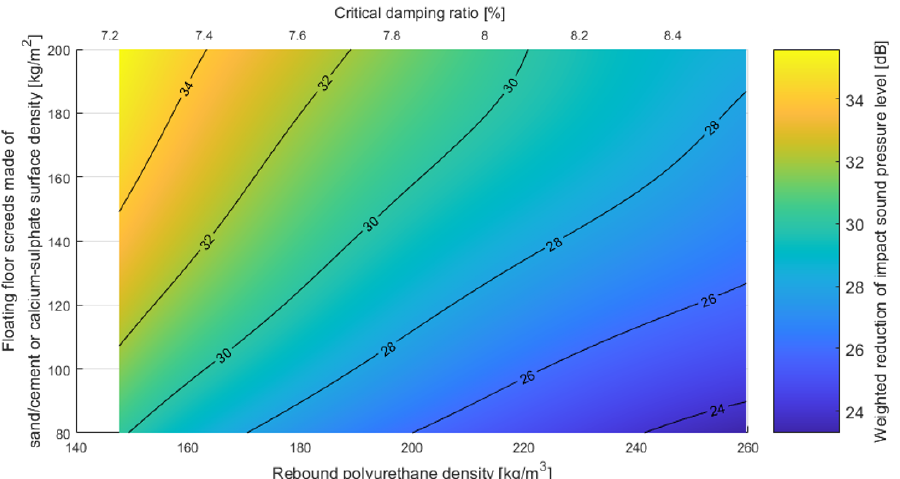
Figure 16. Weighted reduction of impact sound pressure level for asphalt floating floor or dry floating floor constructions with rebound polyurethane foam as a resilient layer, with varying densities and critical damping ratios (own elaboration).